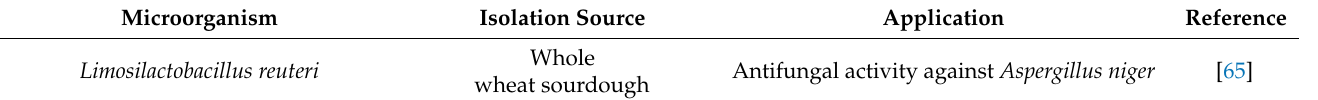
Table 3. Applications biotechnological of lactic acid bacteria